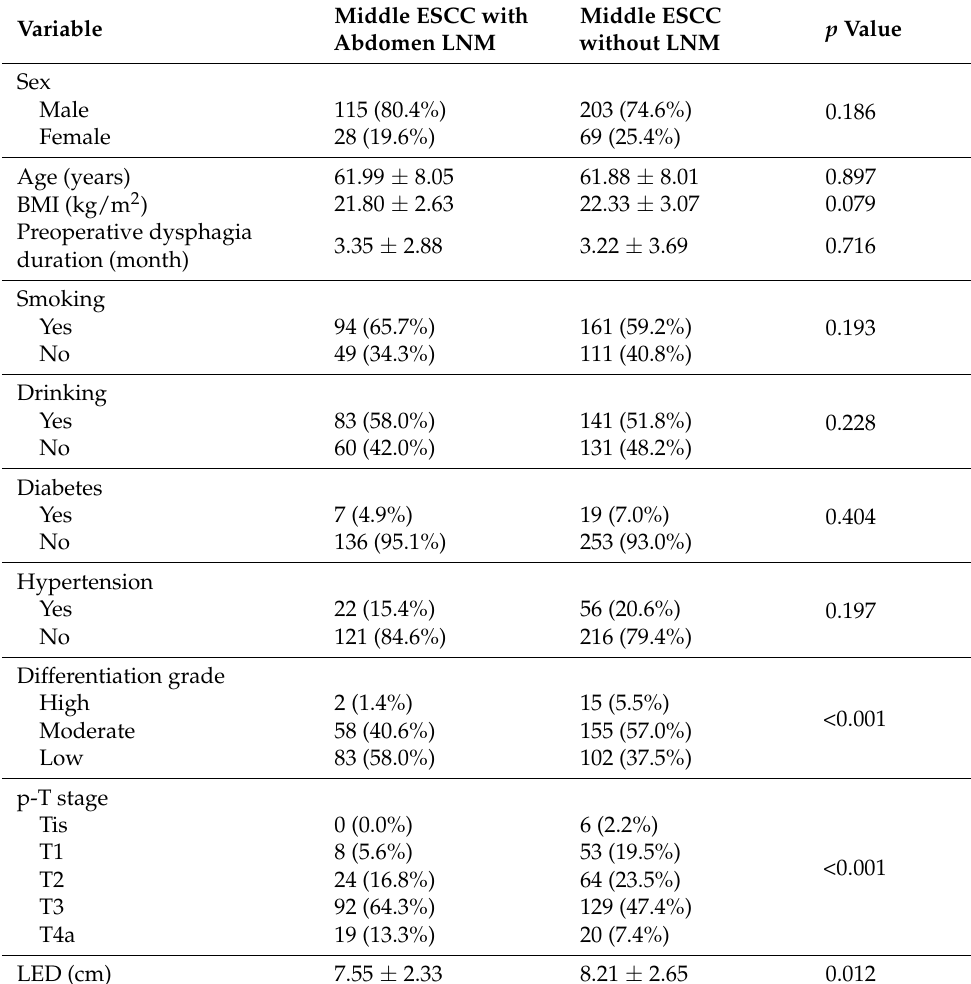
Table 1. Characteristics of middle ESCC patients with abdominal LNM and patients without any